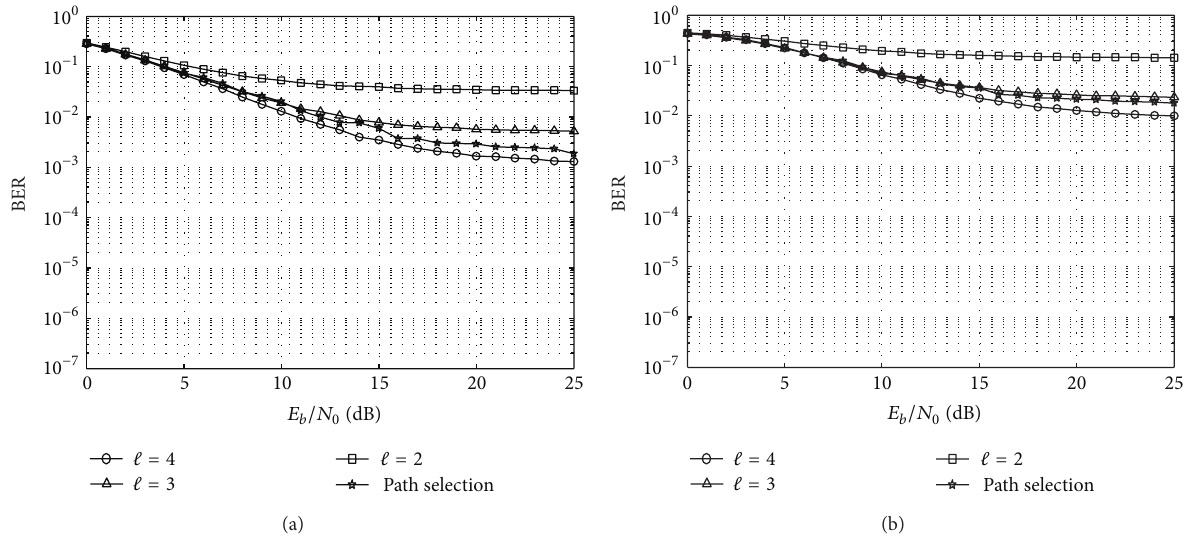
Figure 6: BER performance of OFDM system over the six-path fading channel with 26nsec delay spread for (a) 16-QAM modulation and (b) 64-QAM